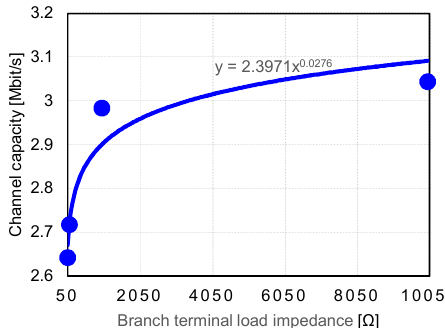
Figure 8. Channel capacity for changing branch terminal load impedance.